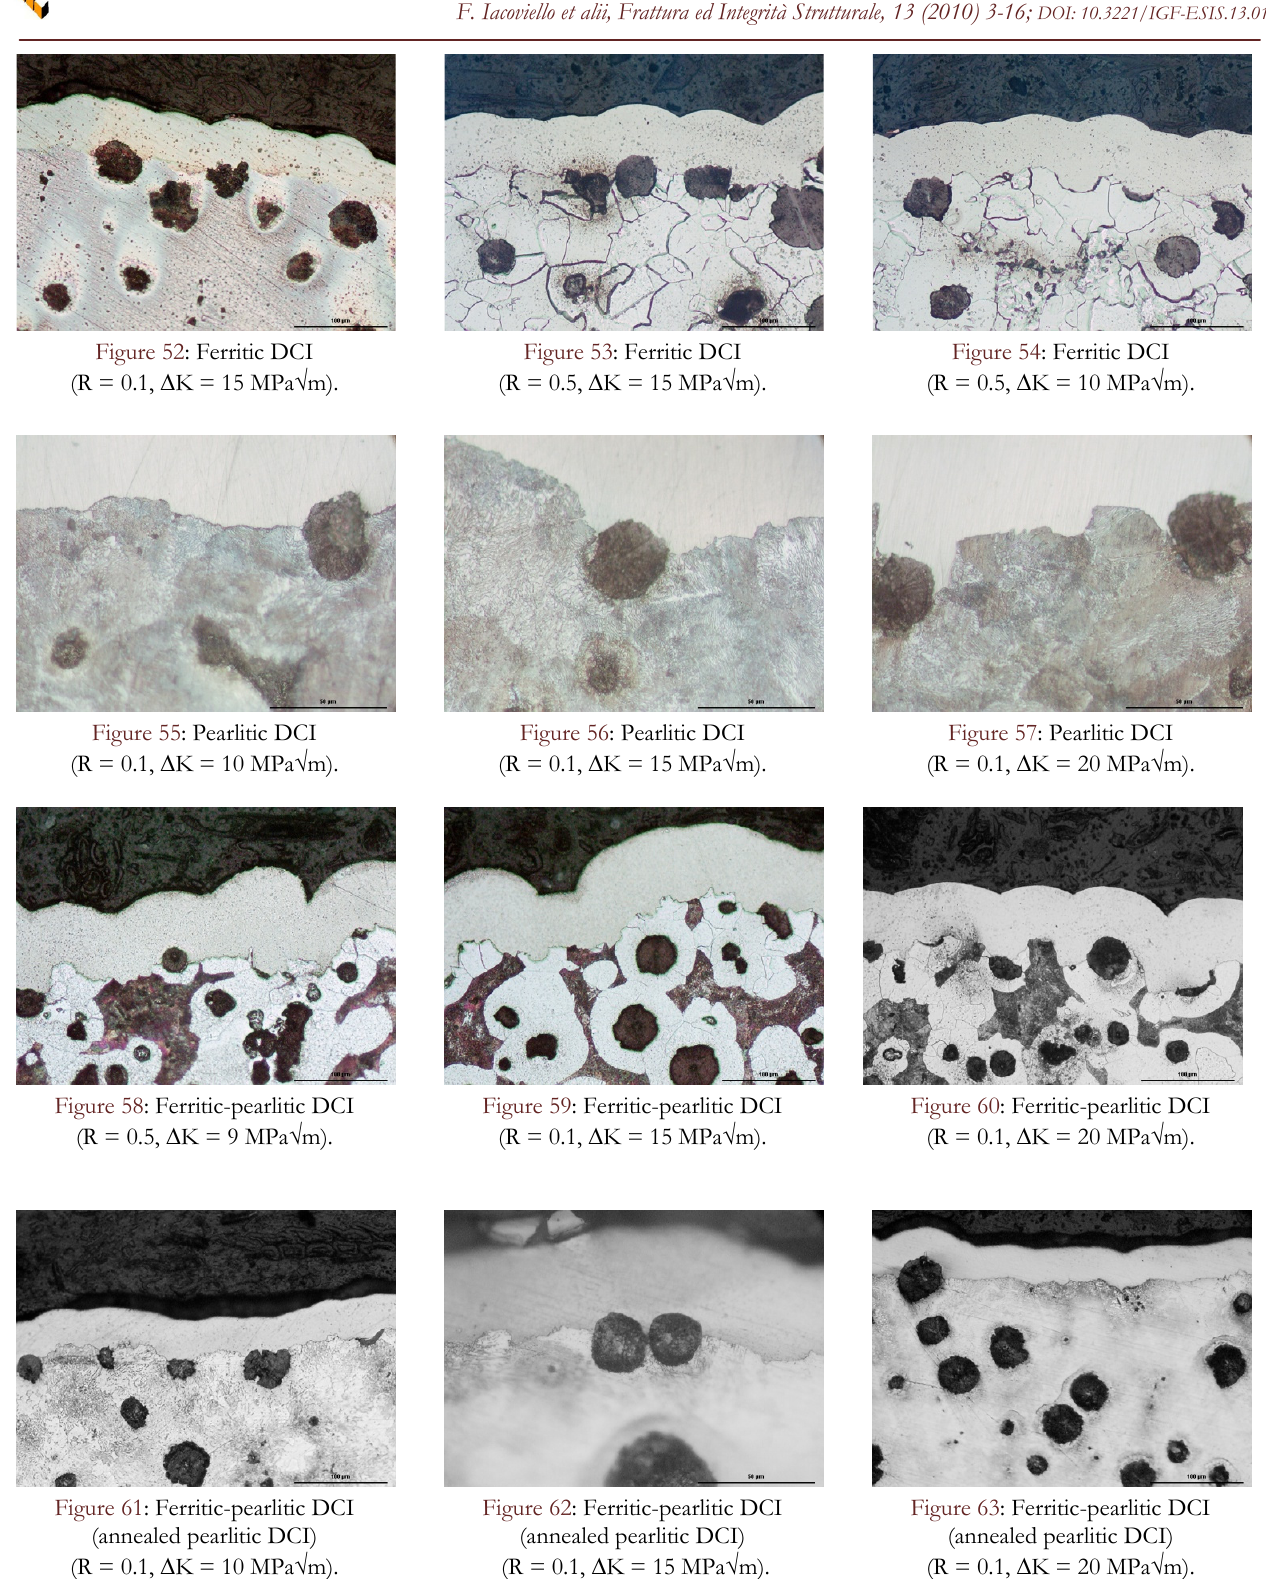
Figure 61: Ferritic-pearlitic DCI (annealed pearlitic DCI) (R = 0.1,  K = 10 MPa √ m).